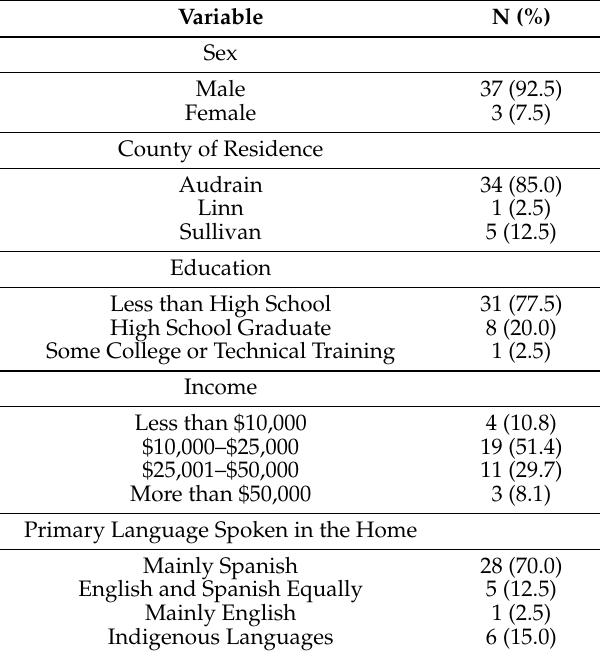
Table 1. Demographic characteristics of